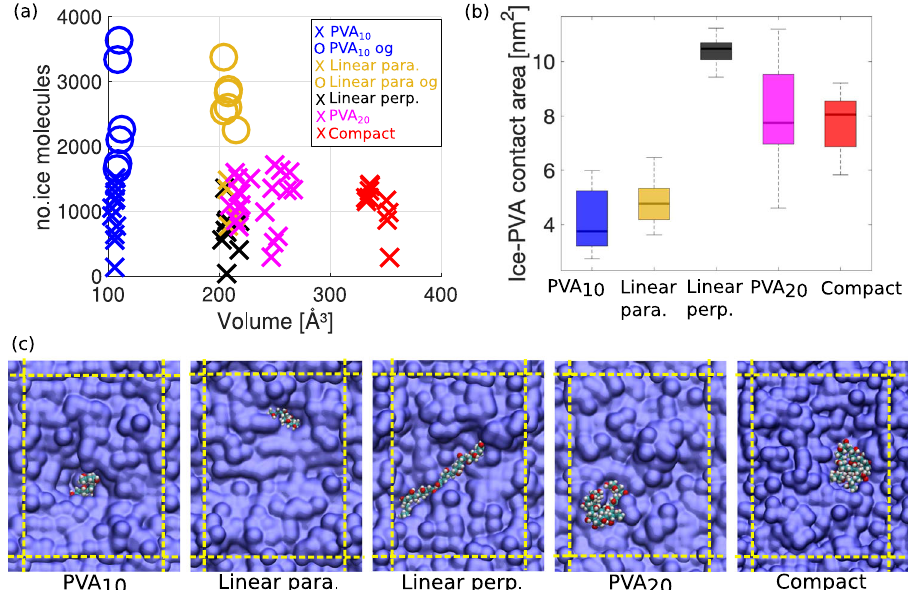
Fig. 6 The IRI activity of PVA depends on its volume/surface area. a Occupied volume of PVA on ice. IRI activity is measured by fi nding the number of ice molecules that make up the ice crystal at the end of the simulation (starting from the time a polymer binds to ice, t – t 0 ) and plotted against the average volume occupied by the polymers. “ o ” indicates a polymer has been overgrown (og) with ice, “ × ” indicates sustained IRI activity. Linear para. and linear perp. refer to the binding orientation to ice, parallel and perpendicular respectively. b Box-and-whisker plot illustrating the spread of the ice-PVA contact area. The upper(lower) bound and the line within each box represent the maximum(minimum) and the median. The extent of the boxes quanti fi es the upper and lower quartiles. c Representative cross-sections (xy-plane) of the system upon binding of PVA, the dotted yellow lines indicate the periodic